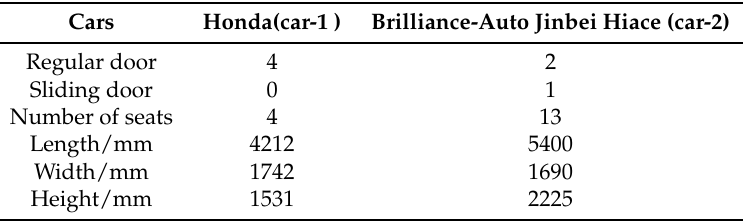
Table 3. The detail of experimental cars.